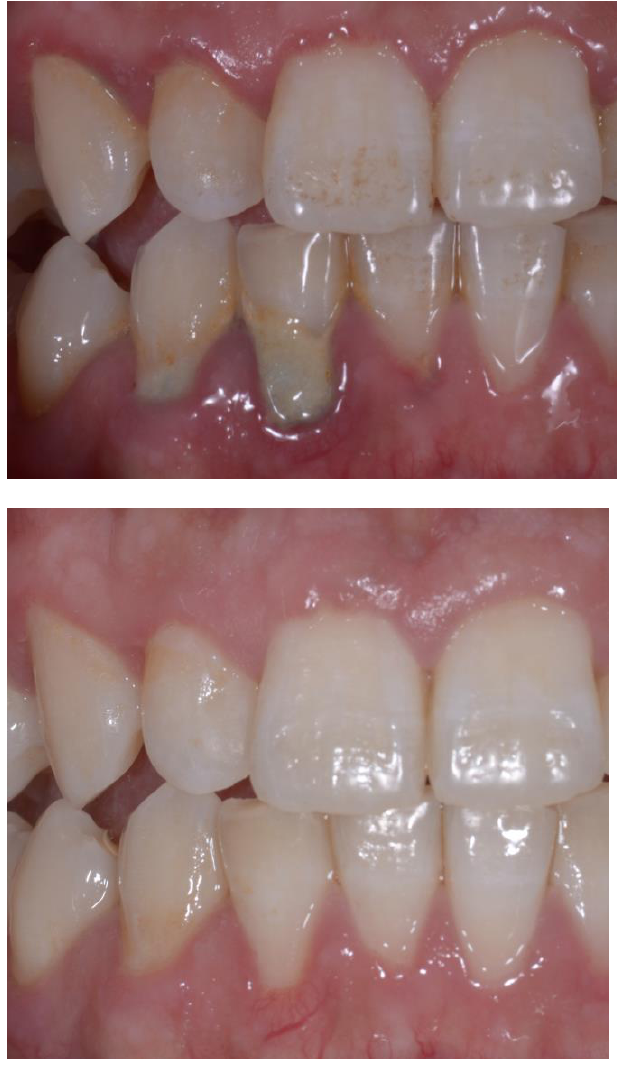
Figure 2. Clinical case before (upper photograph) and after (lower photograph) non-surgical periodontal therapy with the adjunctive use of probiotics.